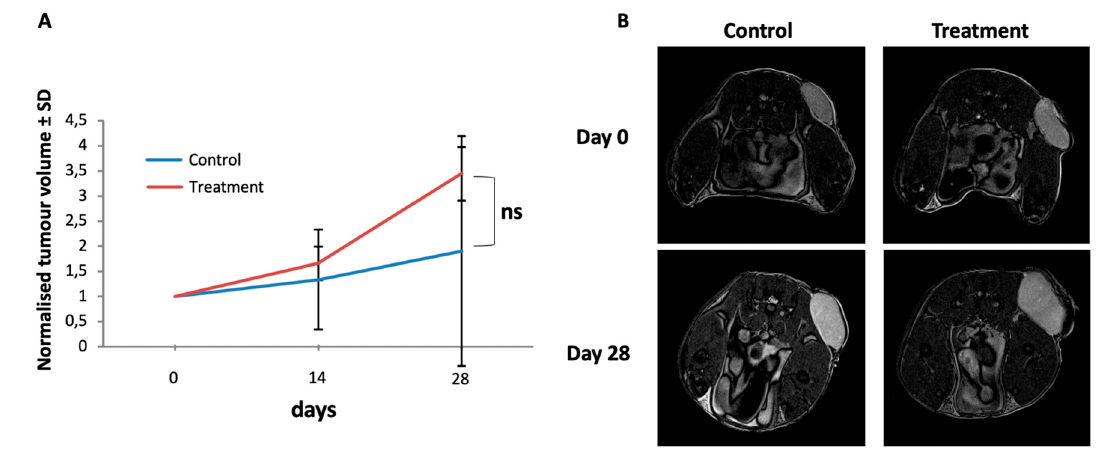
Figure 4. Tumour growth of S462sp cells in a xenotransplantation mouse model is not inhibited by MK-2206 and AZD8055 in vivo. 1 × 10 6 S462sp cells cultivated in a ratio of 1:1 of neurobasal medium and matrigel were subcutaneously injected into the right flank of SCID mice. After the tumour reached 5 mm in maximum diameter, the mice were randomised into either treatment or control group and treated with either the combination of MK2206 and AZD8055 or vehicle only in the control group. The tumour volume was determined using ultrasound on days 0, 14 and 28 and normalised; the mean values and standard deviation of grouped data from both groups ( A ) are shown. Representative MR images (axial T2w turbo-spin-echo sequence; body array coil at 7T, Bruker ClinScan, Ettlingen, Germany) of MPNST-derived xenograft tumours implanted subcutaneously to the left pelvis of the mice on experimental day 0 and 28 demonstrating significant tumour growth in both the treatment- and the control group, respectively. Since the tumours show a homogenous stroma at both timepoints, pseudo progression due to edema or necrosis can be ruled out ( B ).